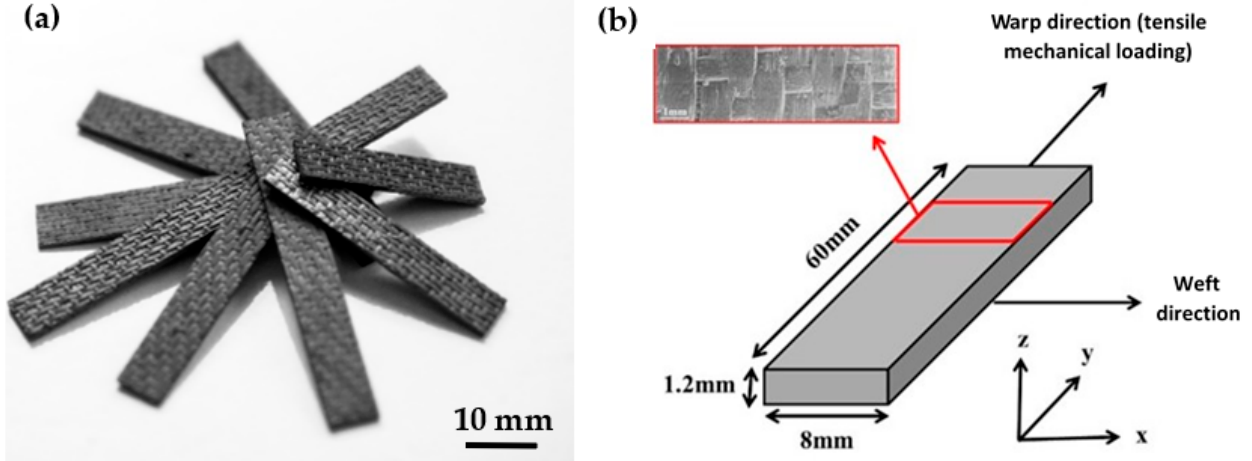
Figure 1. SiC/SiC composites specimens as processed: ( a ) global picture and ( b ) specimen orienta- tions for tensile mechanical tests.